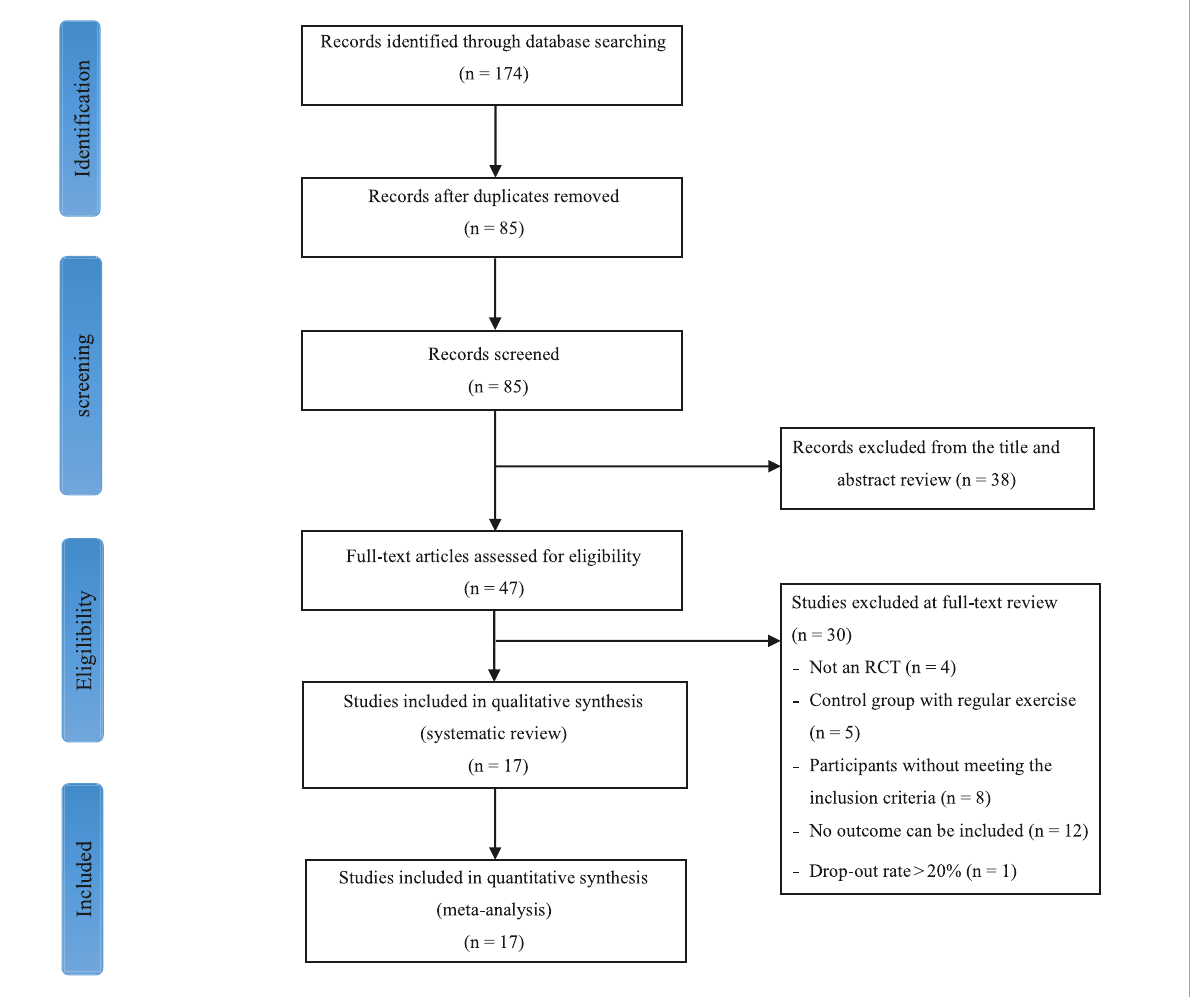
FIGURE1 Flowchart of the process of screening and study